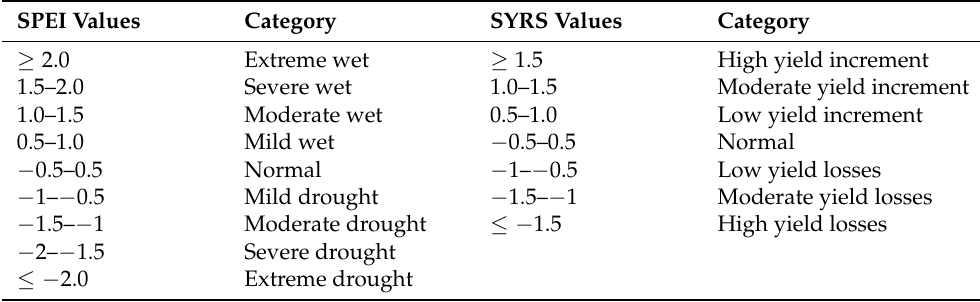
Table 1. Classifications of the SPEI and